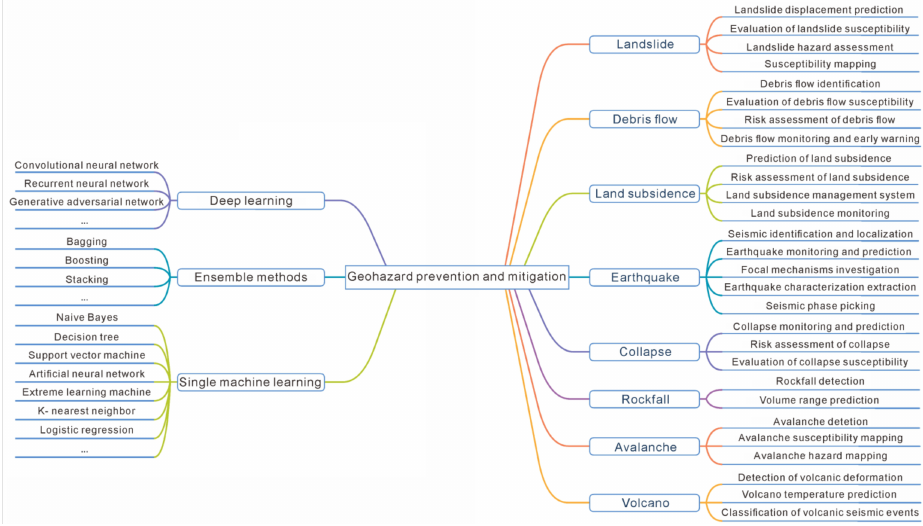
Figure 2. Main AI algorithms and applications in geohazard prevention